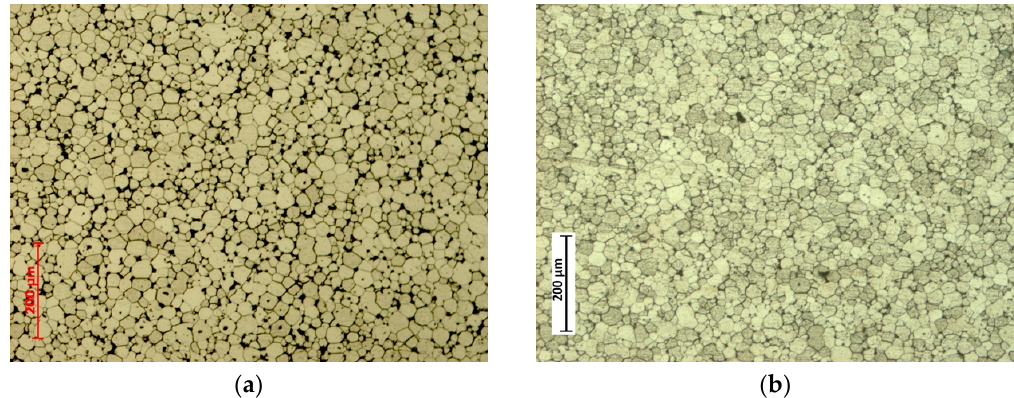
Figure 8. Microstructures after chemical etching of molybdenum powder (Mo-45) after sintering at 1900 °C without holding time: ( a ) under 28MPa and ( b ) under 70MPa applied at 900 °C.